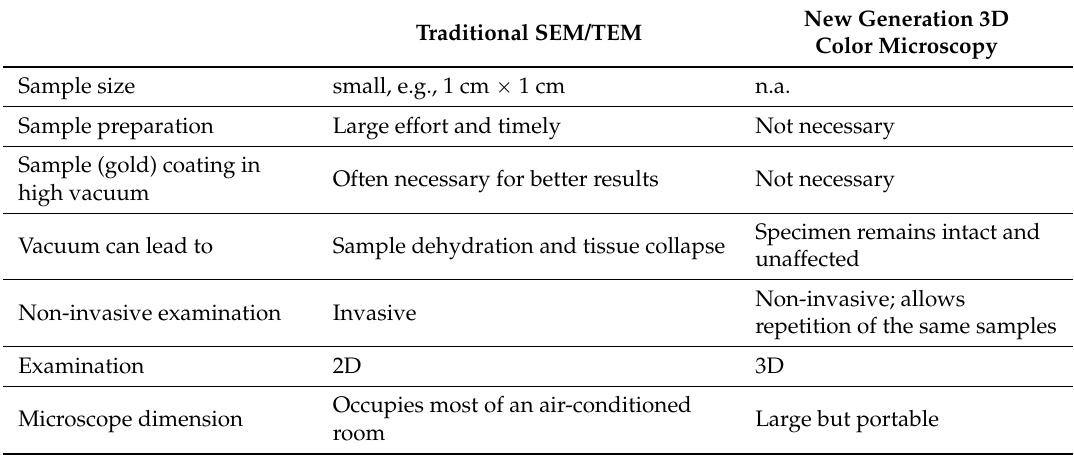
Table 1. Comparison of the new microscopy features with traditional SEM/TEM.